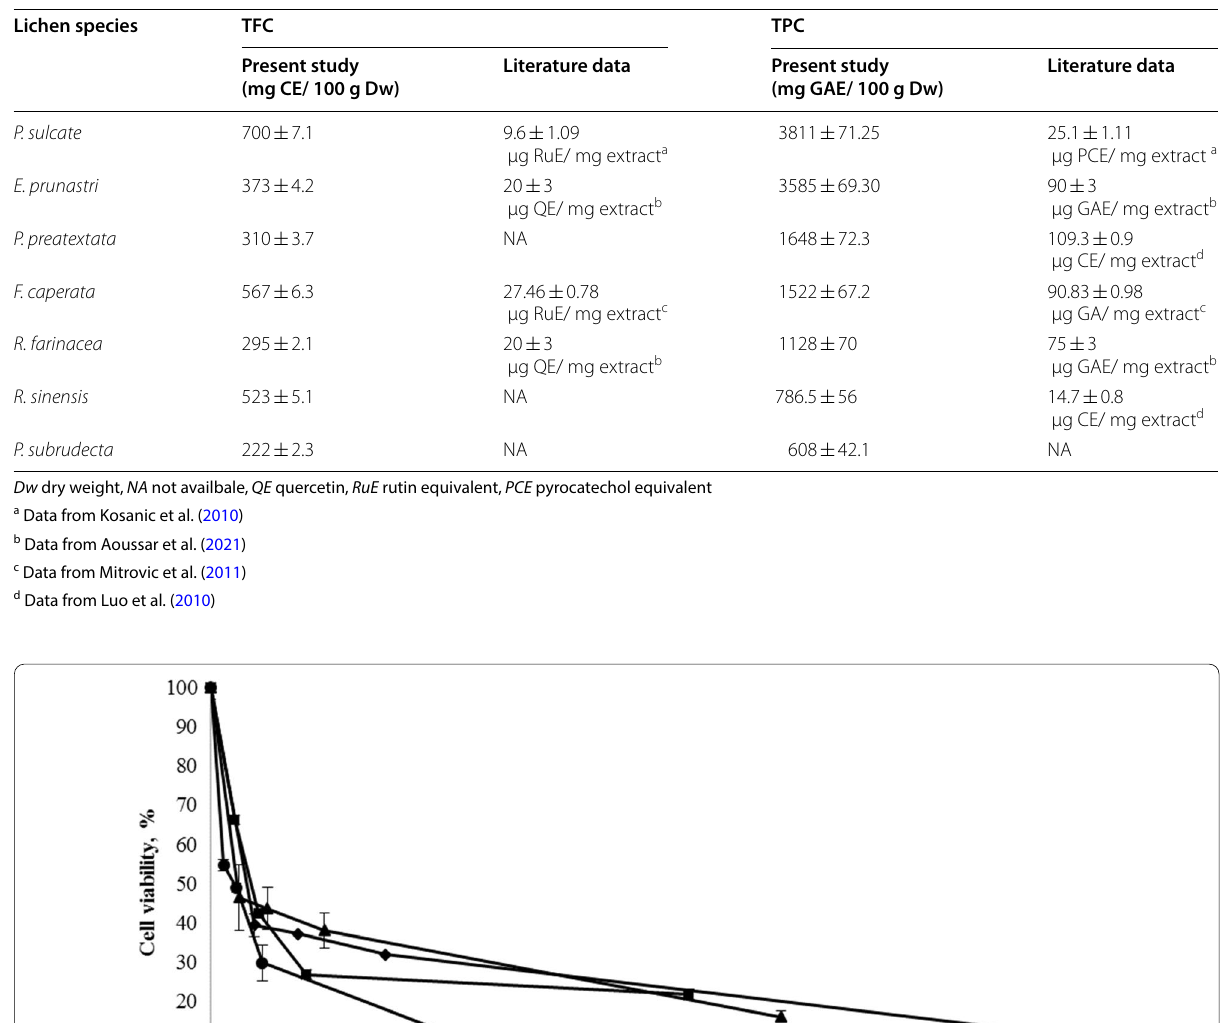
Table 2 TPC and TFC of methanol extracts of lichens